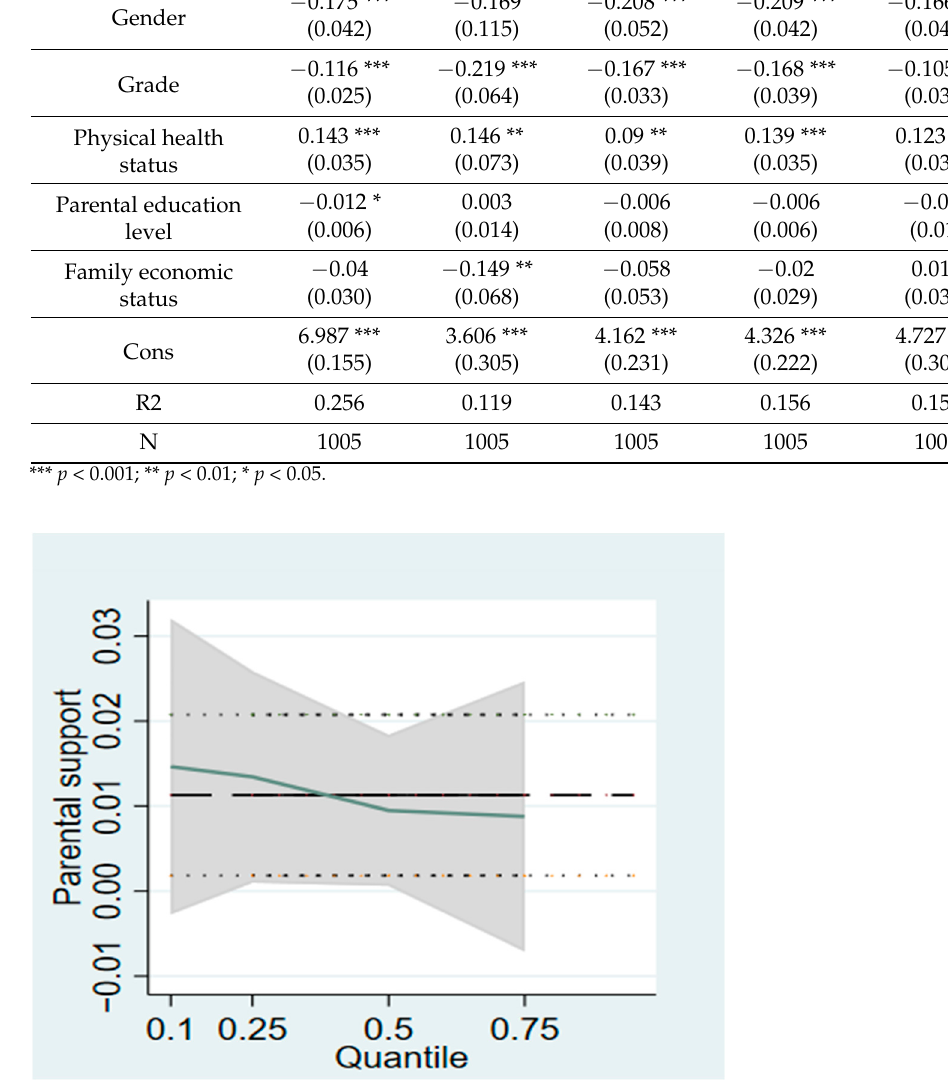
Figure 1. Trend of parental support on physical activity energy expenditure in college students.